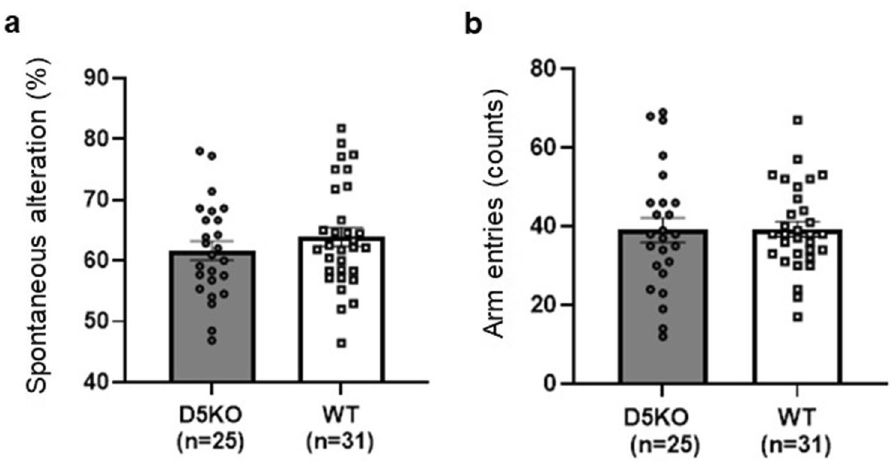
Figure 3. The effects of dopamine D 5 receptor KO on the parameters in the Y maze test. ( a ) The percentage of spontaneous alternation, a measure of working memory, in D5KO mice and their WT littermates. ( b ) The total number of arm entries, a measure of locomotor activity, of D5KO mice and their WT littermates. The data are presented as the means ±